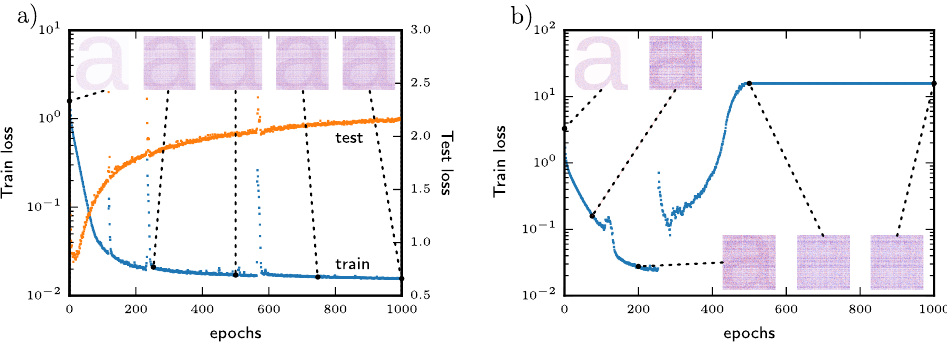
Figure 1. Train and test loss of networks consisting of two equally sized hidden layers of nodes, trained on HASYv2. Some of the weights connecting the two hidden layers were initially set to zero so that the weight matrix of these layers resembles the letter a (at initialization). The evolution of the weight matrix is shown in the subplots. ( a ) Loss of a stable learner network with 512 nodes in each hidden layer. ( b ) Training loss of an unstable network with 256 nodes in each hidden layer, illustrating the effect of crossing over from trainability to untrainability regimes on the network’s weights (disappearance of the initialization mark). A single curve is shown for clarity, but networks of the same width show the same behavior. Experiments with other symbols (that serve as mask for the initialization) exhibit similar